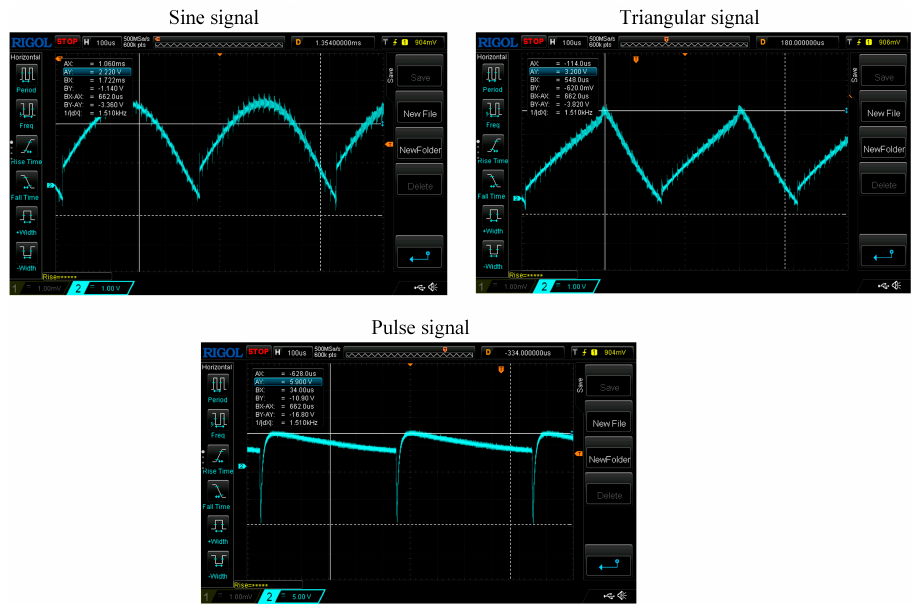
Figure 13. Experimental test of the output signal of the AD630 chip under 3 excitation signals.